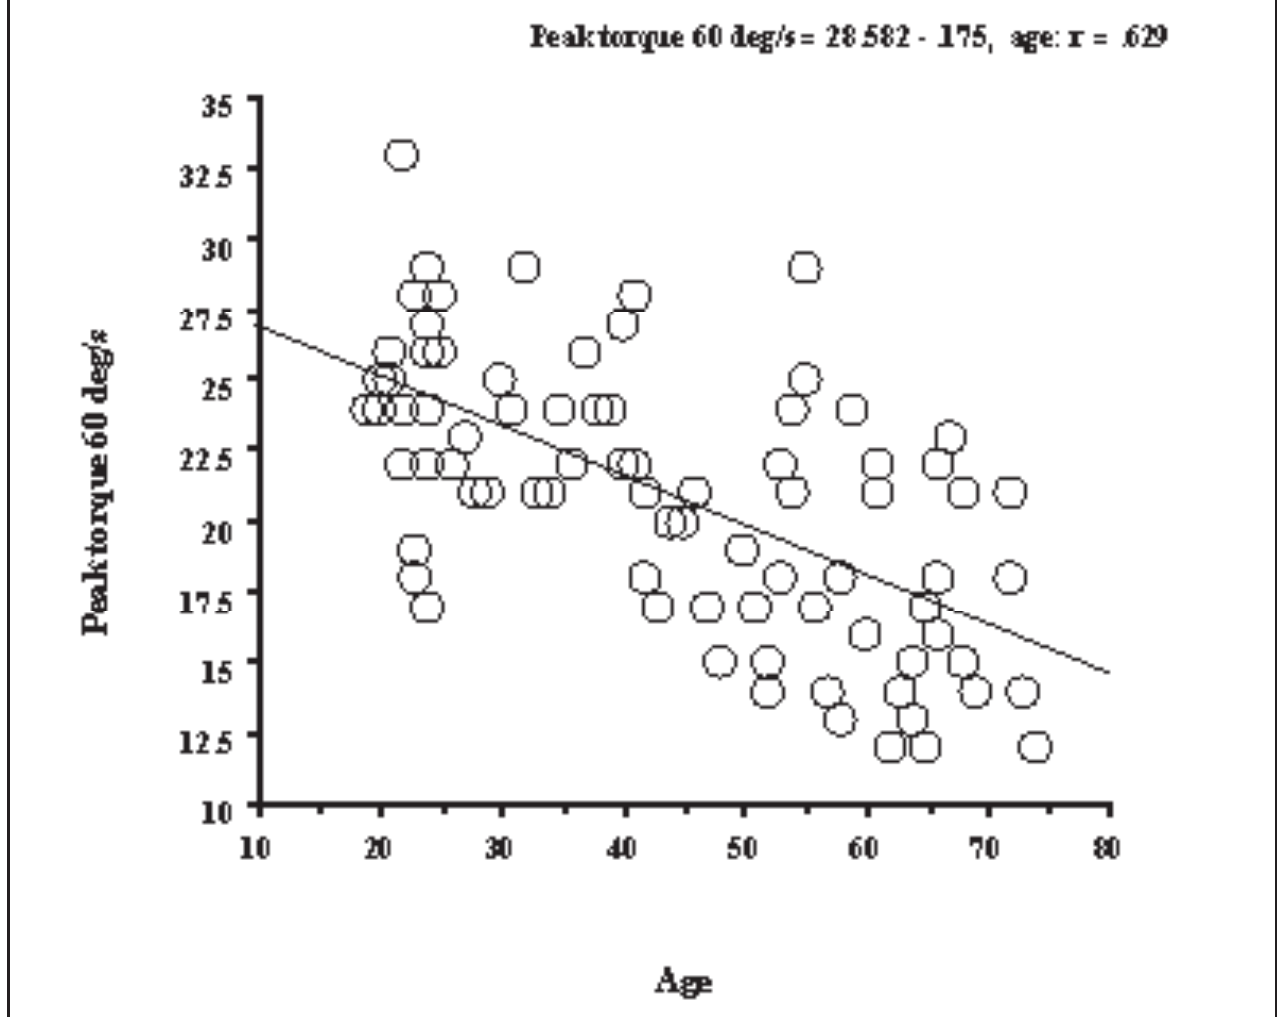
Fig. 2(A): Significant correlation was observed for external rotation peak torque at both velocities with aging. (A: 60 deg/s angular velocity, r = 0.629, p